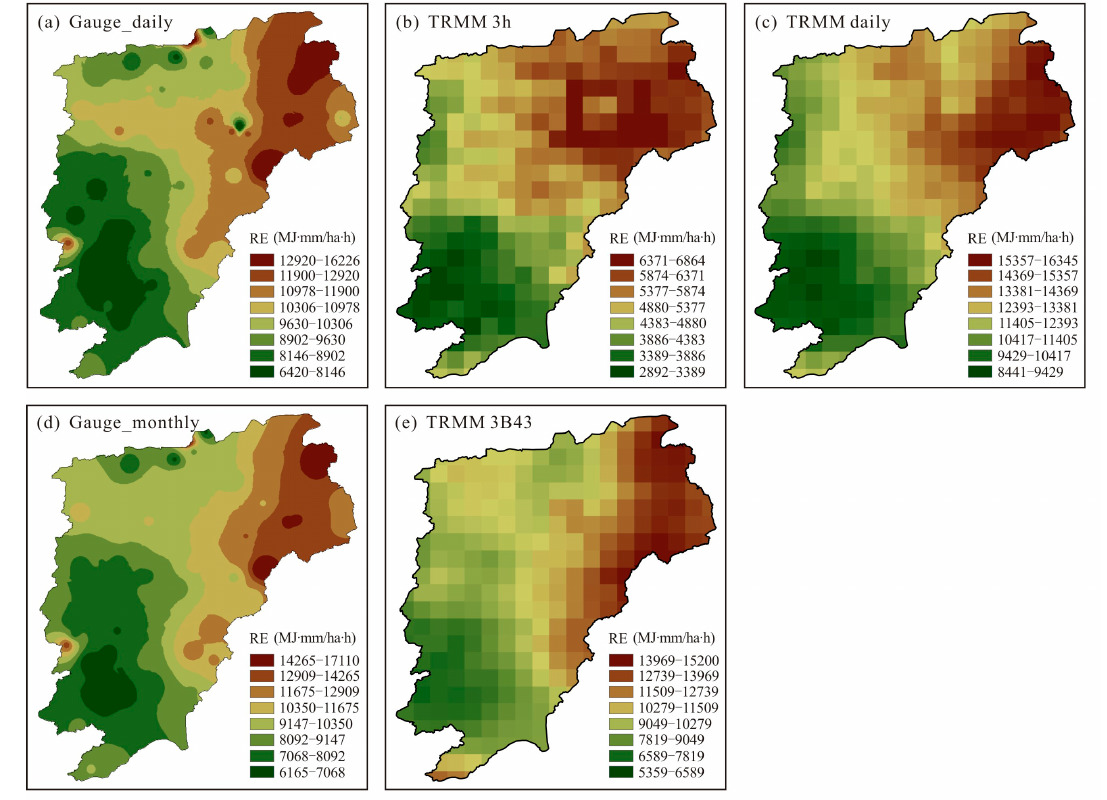
Figure 9. Spatial patterns of average annual RE estimated by rainfall data with different temporal resolutions.